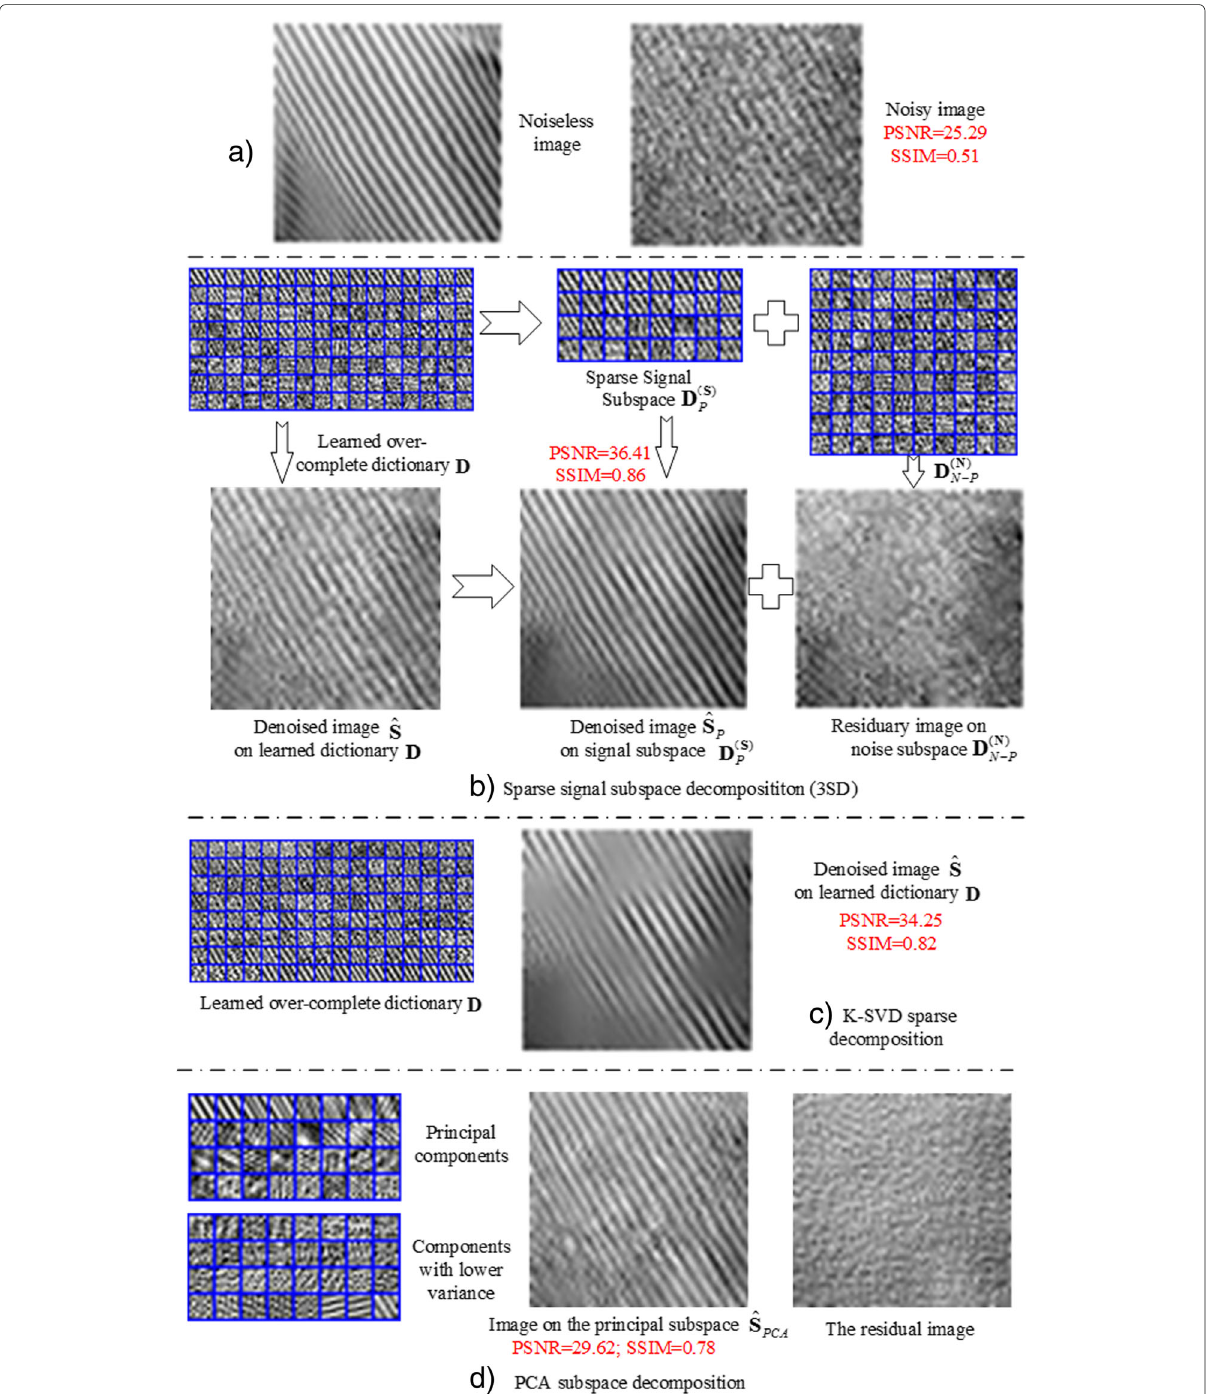
Fig. 4 Signal decompositions. a Image sample. b Sparse Subspace decomposition. c Sparse decomposition. d Subspace decomposition